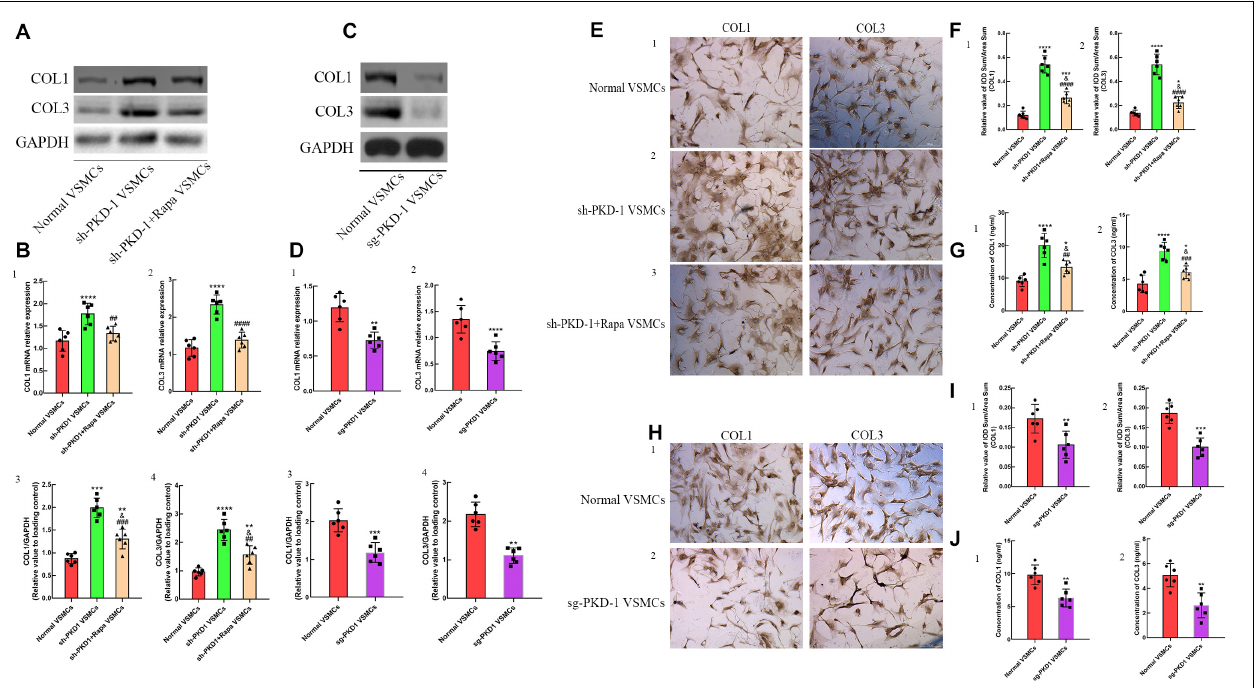
FIGURE 4 | The synthesis, secretion and deposition of collagens when the expression of PC-1 was inhibited or enhanced. Increased synthesis of (A,B1,3) collagen I ( p < 0.0001, p = 0.0003) and (A,B2,4) collagen III ( p < 0.0001, p < 0.0001) in sh-PKD-1 VSMCs compared with normal VSMCs. Enhanced secretion of (G1 ) COL1 ( p < 0.0001) and (G2) COL3 ( p < 0.0001) in sh-PKD-1VSMCs compared with normal VSMCs. Increased deposition of COL1 ( p < 0.0001) and COL3 ( p < 0.0001) in sh-PKD-1 VSMCs compared with normal VSMCs. sh-PKD-1 + Rapa VSMCs exhibited suppressed synthesis of ( A,B1,3) COL1 ( p = 0.0044, p = 0.0003) and (A,B2,4) COL3 ( p < 0.0001, p = 0.0014) compared with sh-PKD-1 VSMCs. (E1) Showed the ICC results of COL1 and COL3 in normal VSMCs. sh-PKD-1 + Rapa treatment also inhibited the (G1,2 ) secretion ( p = 0.0031, p = 0.0006) and (E2,3,F1,2) deposition ( p < 0.0001, p = 0.0006) of COL1 and COL3 compared with sh-PKD-1 VSMCs. Treatment of sg-PKD1 inhibited the synthesis of (C,D1,3 ) COL1 ( p = 0.0006, p = 0.0004) and (C,D2,4) COL3 ( p = 0.0009, p < 0.0001) compared with normal VSMCs. The (J1,2) secretion ( p = 0.0015, p = 0.0017) and (H1,2,I1,2) deposition ( p = 0.0088, p = 0.0001) of COL1 and COL3 were also suppressed in sg-PKD-1 VSMCs compared with normal VSMCs. * p < 0.05, ** p < 0.01, *** p < 0.001, **** p < 0.0001 (compared with normal VSMCs); ## p < 0.01, ### p < 0.001 (compared with TAD VSMCs). ####Means the comparison between sh-PKD1 and sh-PKD1 + Rapa VSMCs. p <